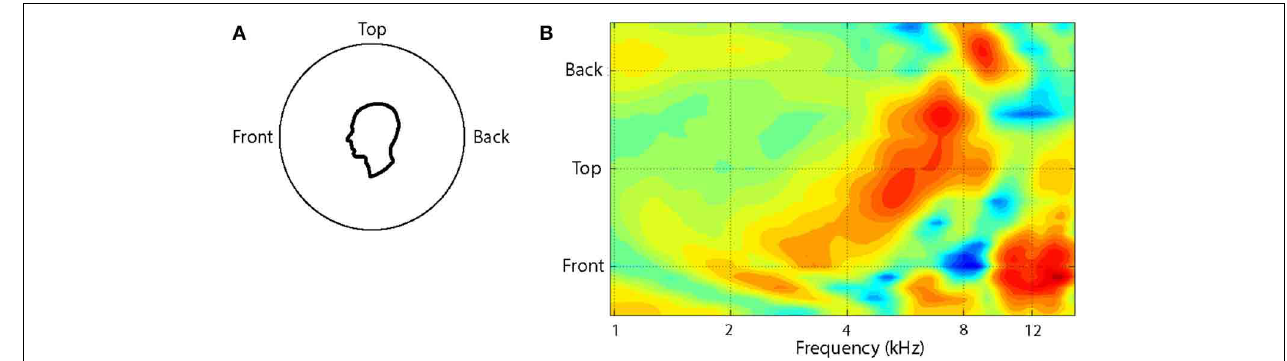
were not done for locations greater than 45 ◦ below the audio-visual horizon. The colors of the contours indicate the amplitude of the function at each frequency, location conjunction and extend from 12dB (dark red) to − 15dB (dark